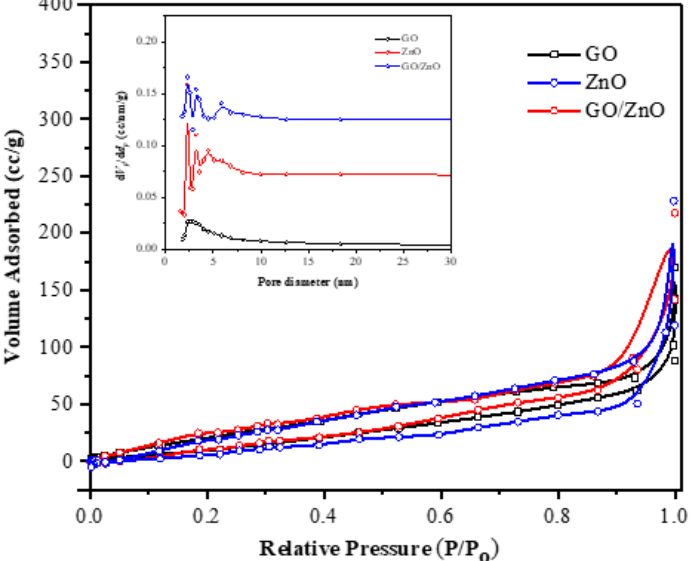
Table 1. Surface area parameters obtained from BET surface area analyzer.